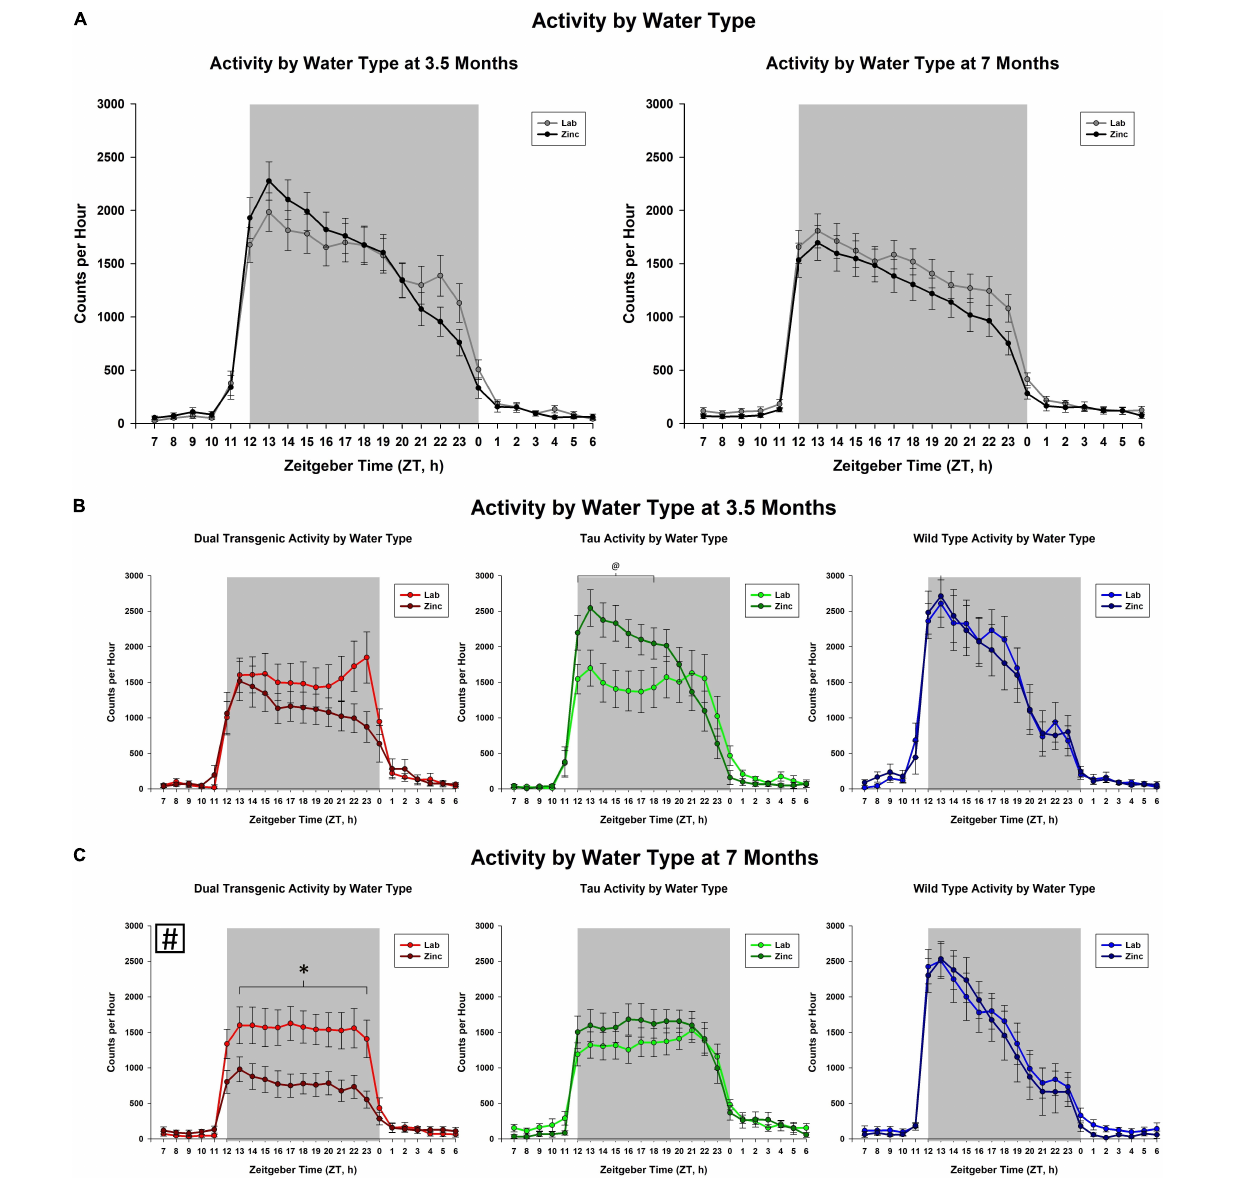
FIGURE 2 | Comparison of dark cycle activity by (A) water type by age, (B) water type by genotype at 3.5 months, and (C) water type by genotype at 7 months. Tau animals exclusively showed a trend for increased activity from ZT 13-15 ( # ) when administered Zn at 3.5 months. Dual Tg animals on Zn were significantly less active than all other groups except tau lab at 7 months ( ∗ p < 0.05, @ p < 0.10, boxed # indicates a change summed across dark cycle